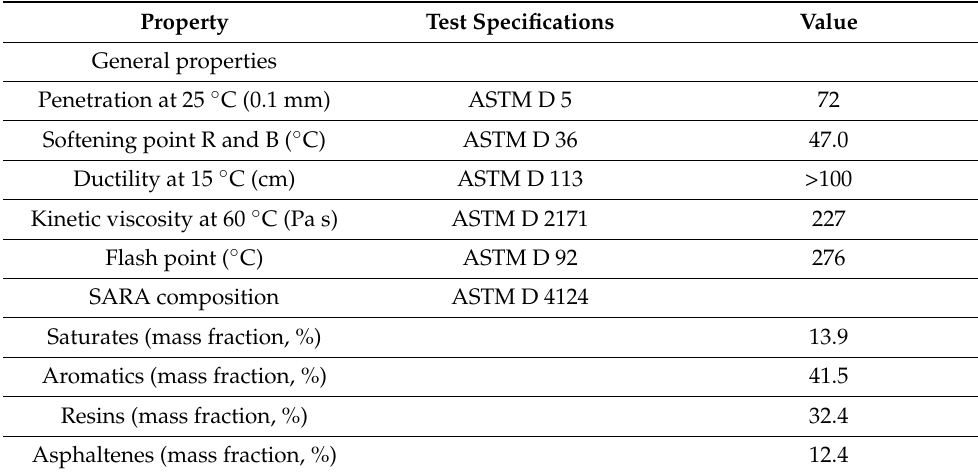
Table 1. Properties of the base